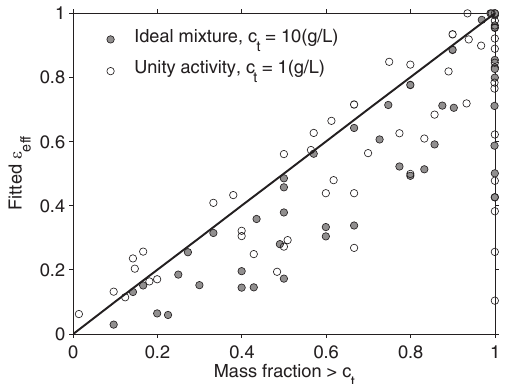
Figure 11. The relationship between the fitted dissolved fraction ε eff at the point of activation and the mass fraction over the me- dian c t for all the considered mixtures and s = 1, 0.6, 0.3 and 0.1%. Closed symbols: the ideal organic mixture assumption (me- dian c t = 10gL − 1 ). Open symbols: the unity activity assumption for the organics (median c t = 1gL − 1